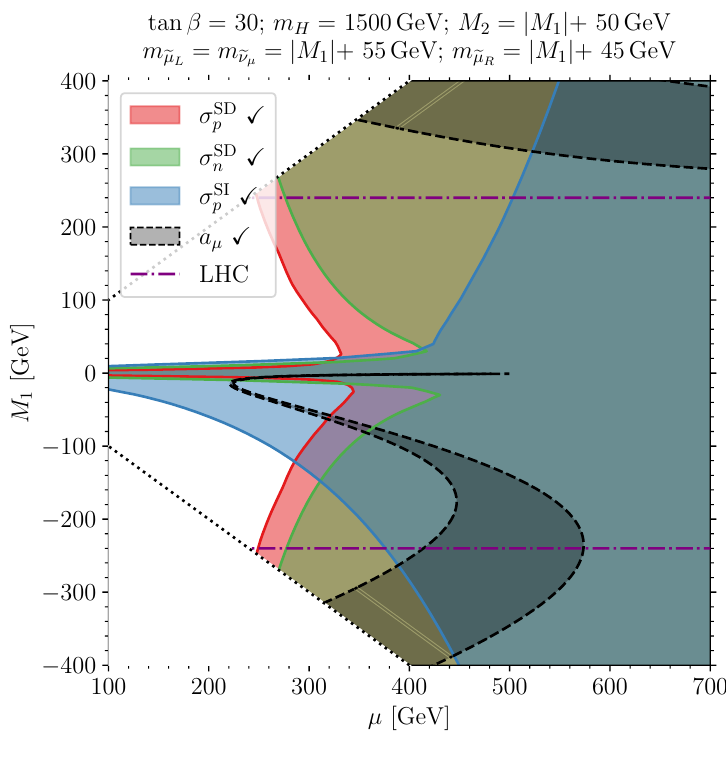
Figure 2 . Same as figure 1 but for tan β = 30 and m H = 1500